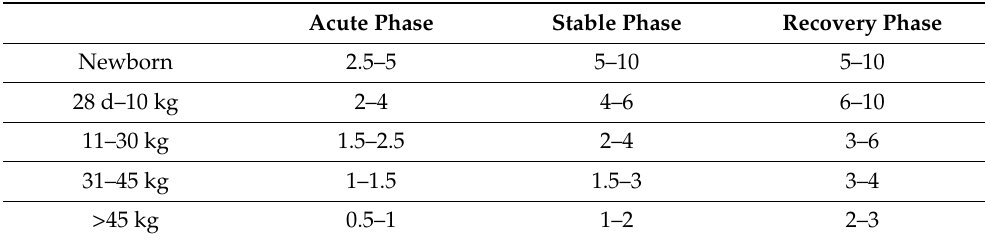
Table 2. The carbohydrate (mg/kg/min) intake during the different phases of critical illness (Ref.